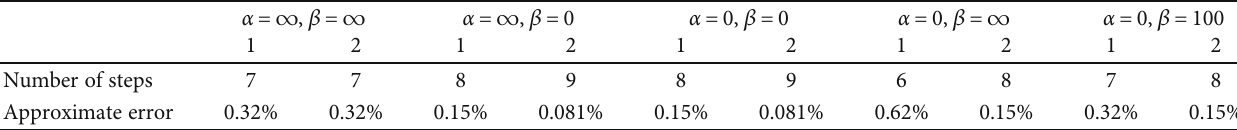
Table 4: The number of steps, used to obtain size values of ~ c , and approximate error. α = ∞ , β = ∞